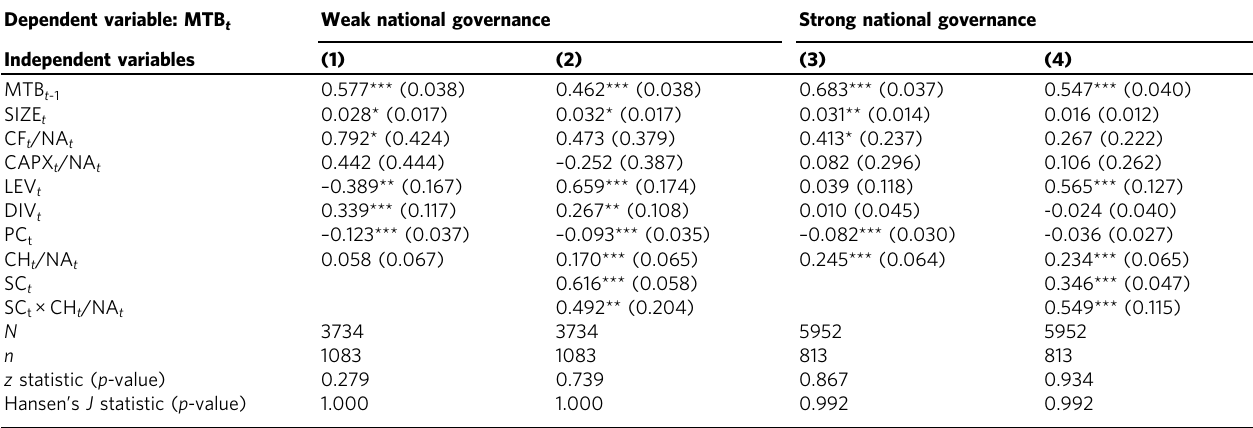
Table 5 Sharia compliance, national governance, and value of cash — sample partitions by national governance. Dependent variable: MTB